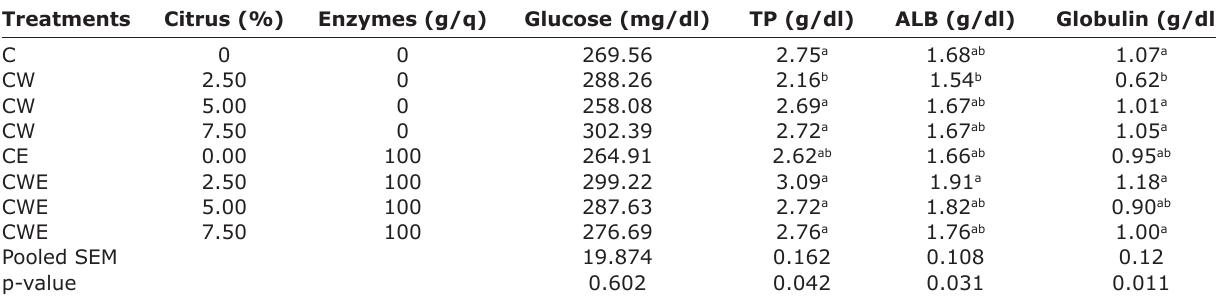
Table-9: Effect of citrus waste×enzyme on the blood parameters of broiler. Treatments